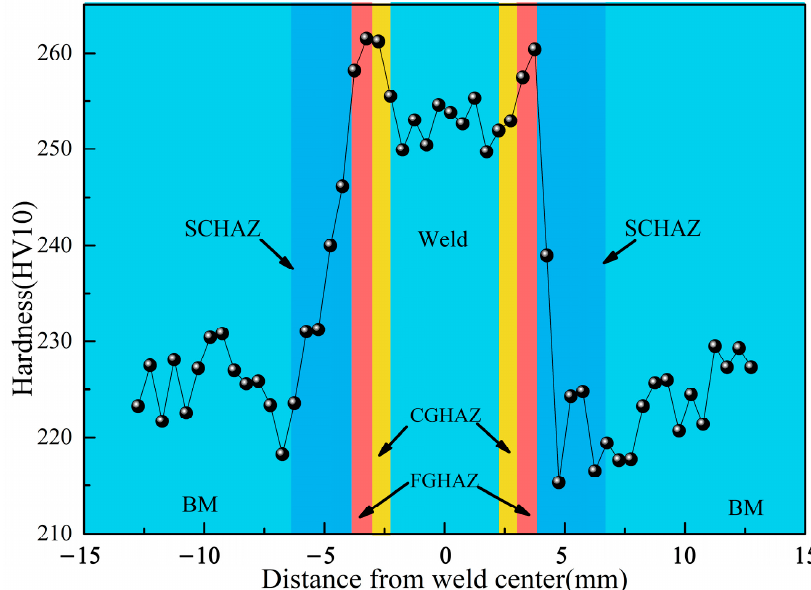
Figure 5. Hardness distribution of the X80 welded joint.